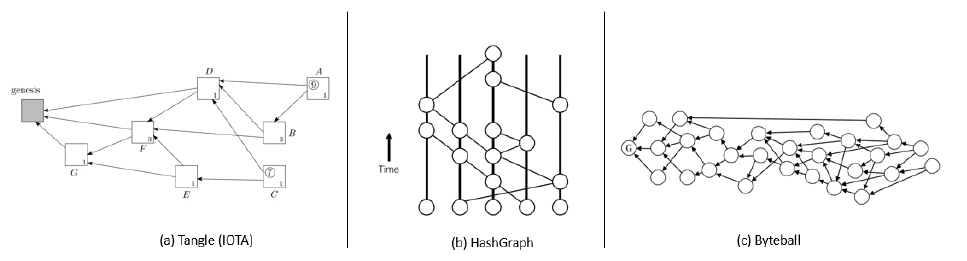
Figure 9. Comparison of direct acyclic graph-based